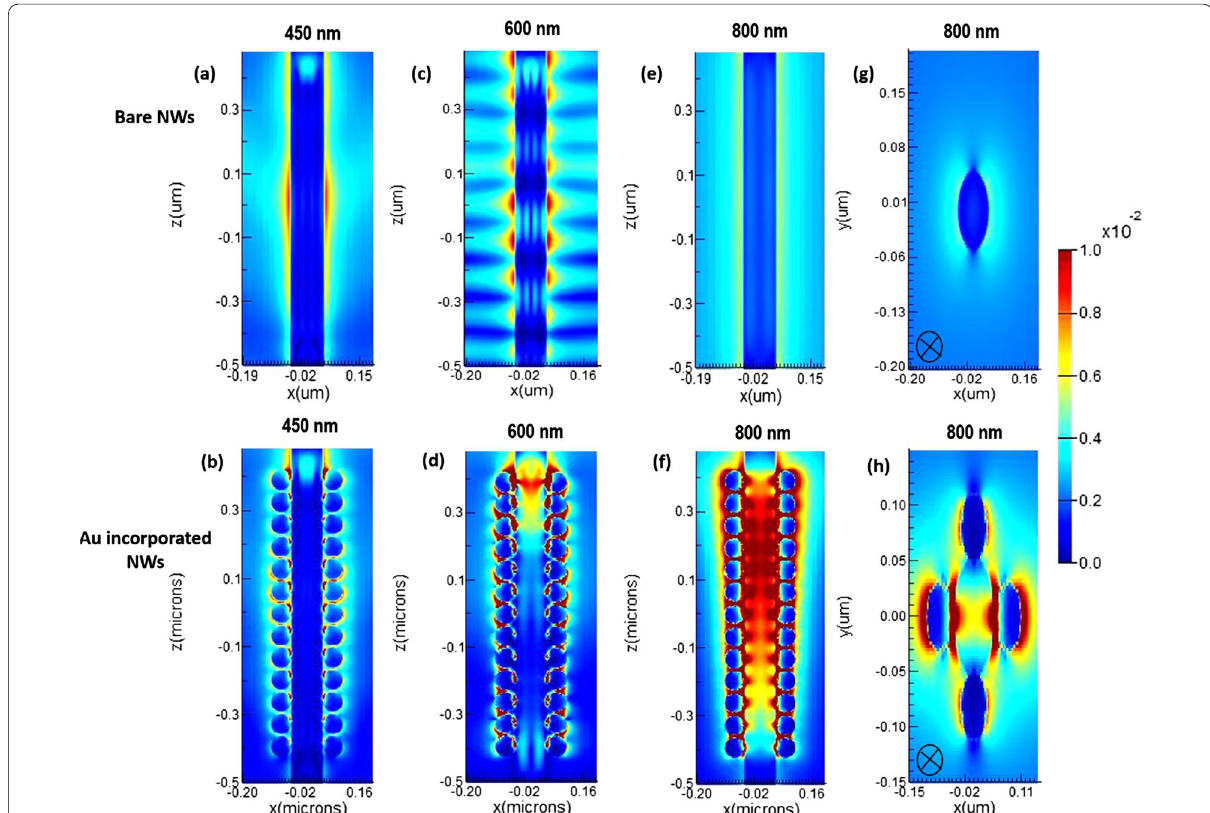
Fig. 8 The absorption, scattering, and extinction cross sections (absorption b for NW decorated with 60 Au NPs (maximum 26 NPs),